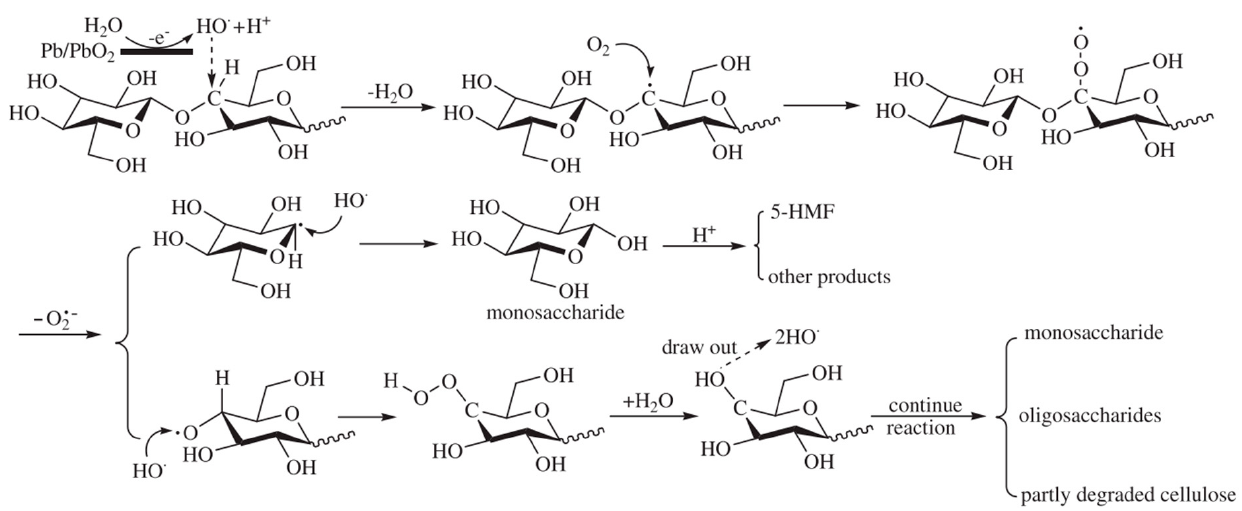
Figure 7. Proposed cellulose depolymerization mechanism in acidic media. Reprinted with permission from Ref. [42]. Copyright 2011, Polymer Degradation and Stability.